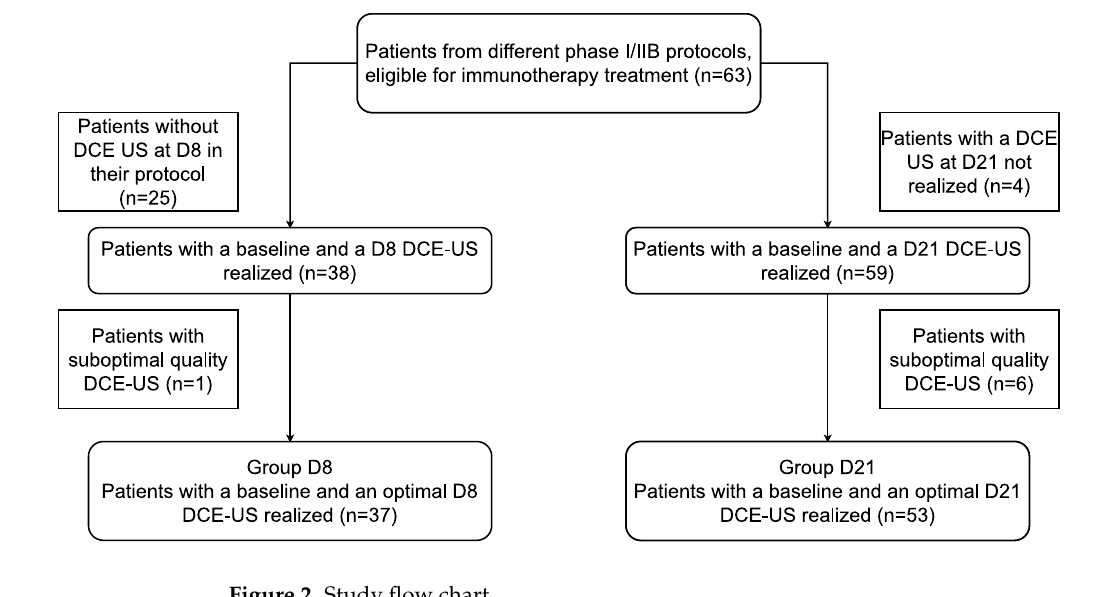
Figure 2. Study flow chart.